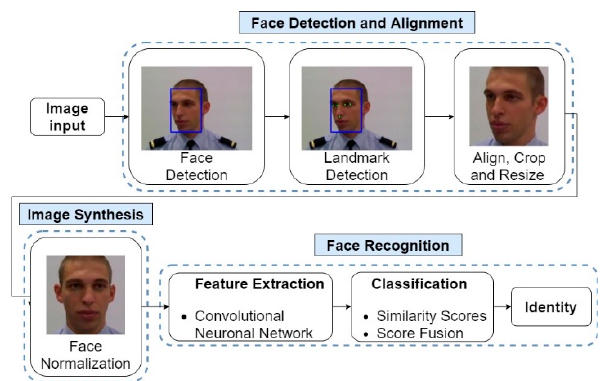
Figure 2. Schematic of the operation of the proposed face recognition